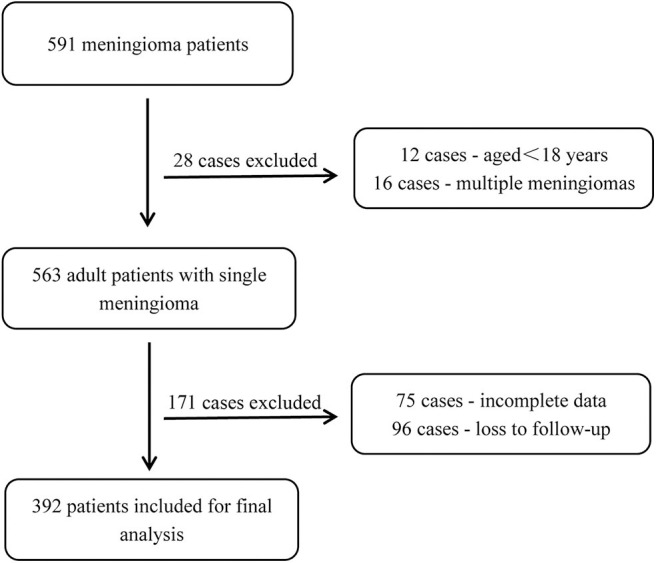
Flowchart of the patient selection process.